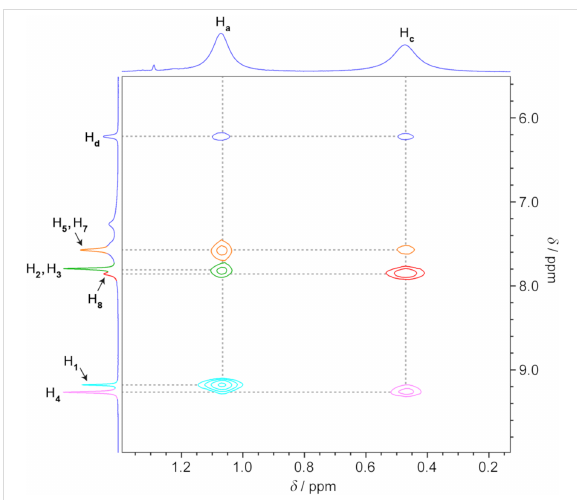
Figure 2: Partial 1 H- 1 H NOESY NMR spectrum of ( E - 1 ) 2 2 showing NOE correlations between host 2 and guest 1 (500 MHz, D 2 O, 298 K) (the corresponding full-range spectrum is shown in Figure S6, Support- ing Information File 1).